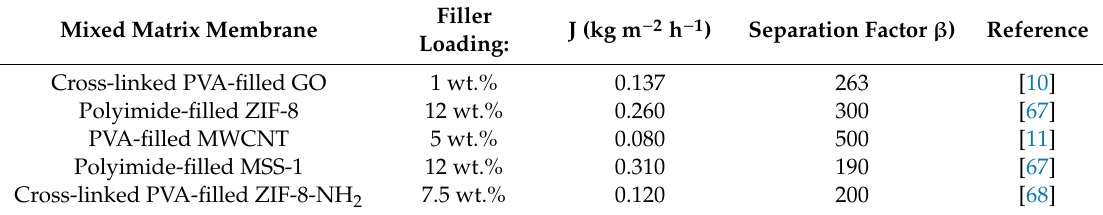
Separation Factor β ) Reference